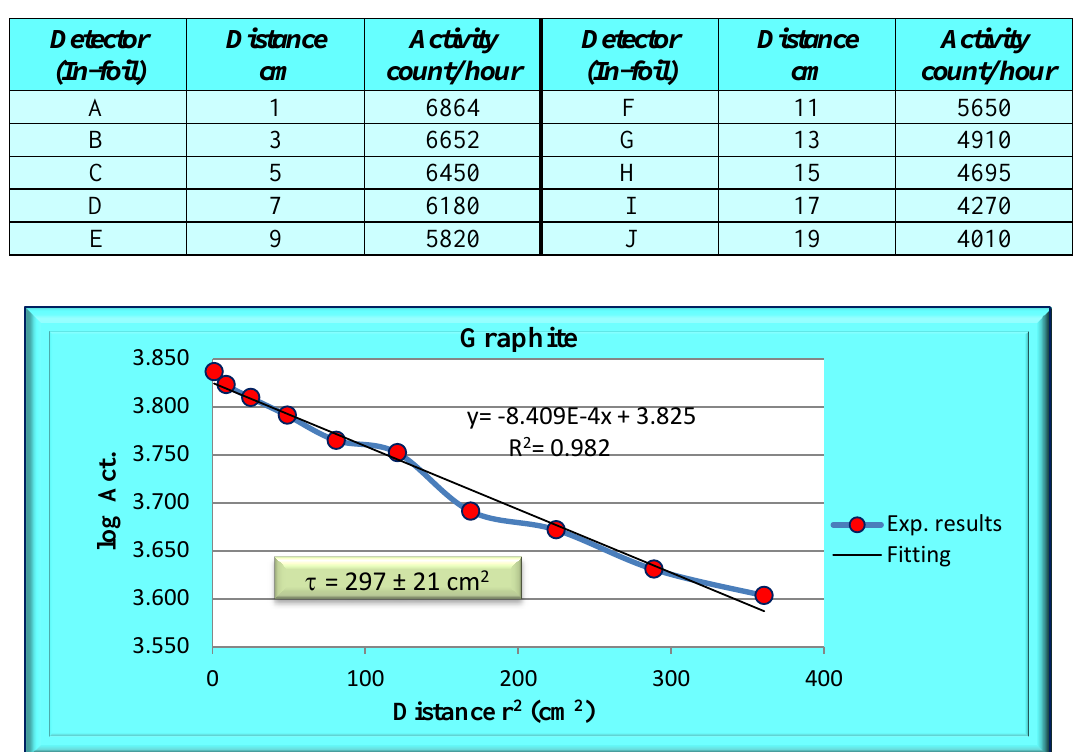
Table 1: Activity measurement of Indium foils in Graphite material.